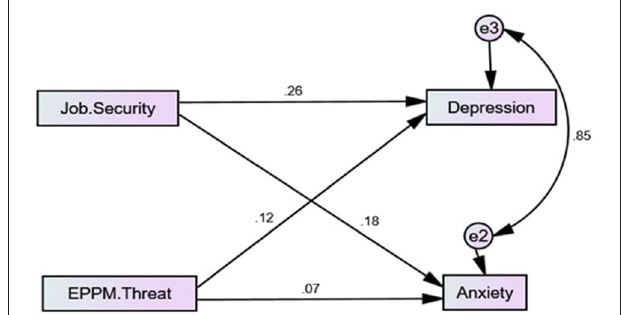
FIGURE 3 | Improved structural model.